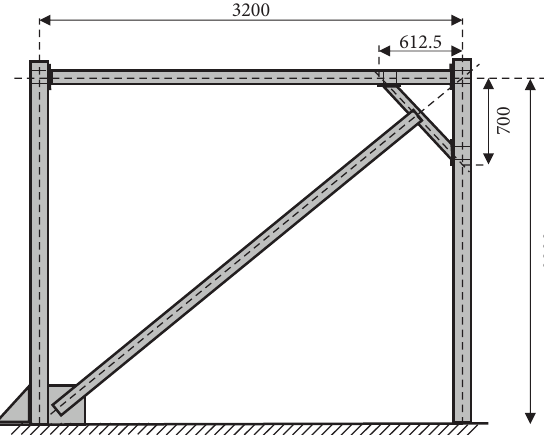
Figure 2: Te KBF system made by Balendra (dimensions in mm).